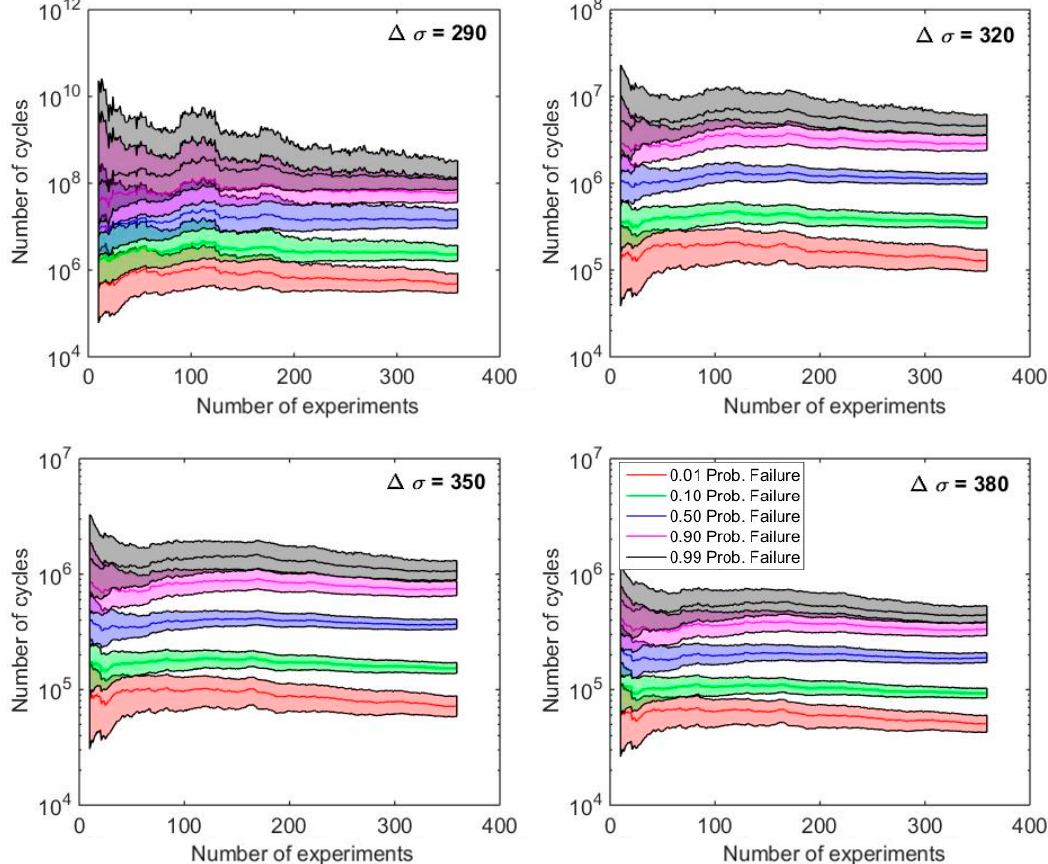
Figure 10. Detailed evolution of the quantiles and confidence intervals with the number of tests involved in the fitting process for different stress levels.